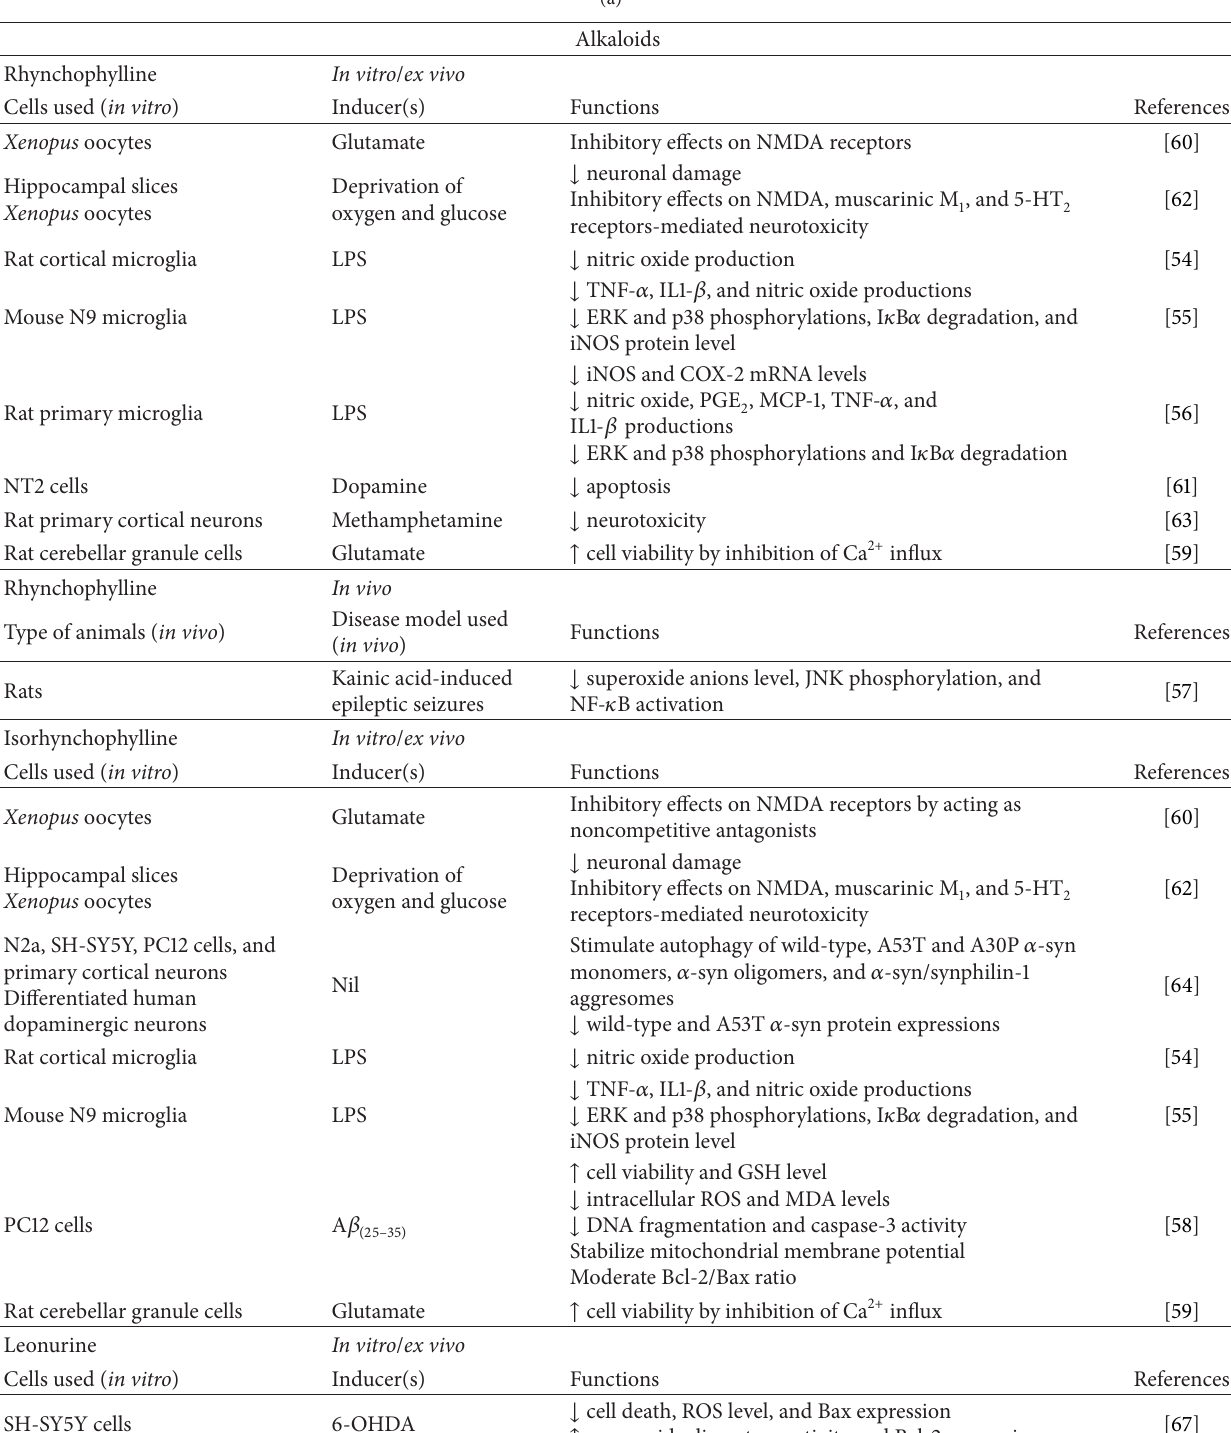
Table 1: Summary of the effects of different bioactive compounds in GUD on neurodegenerative